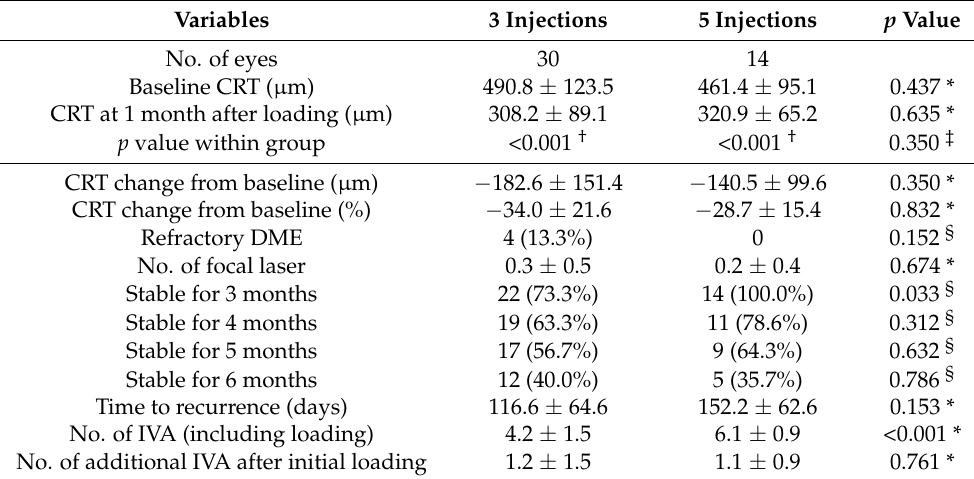
Table 2. Clinical outcomes through 6 months of follow-up.